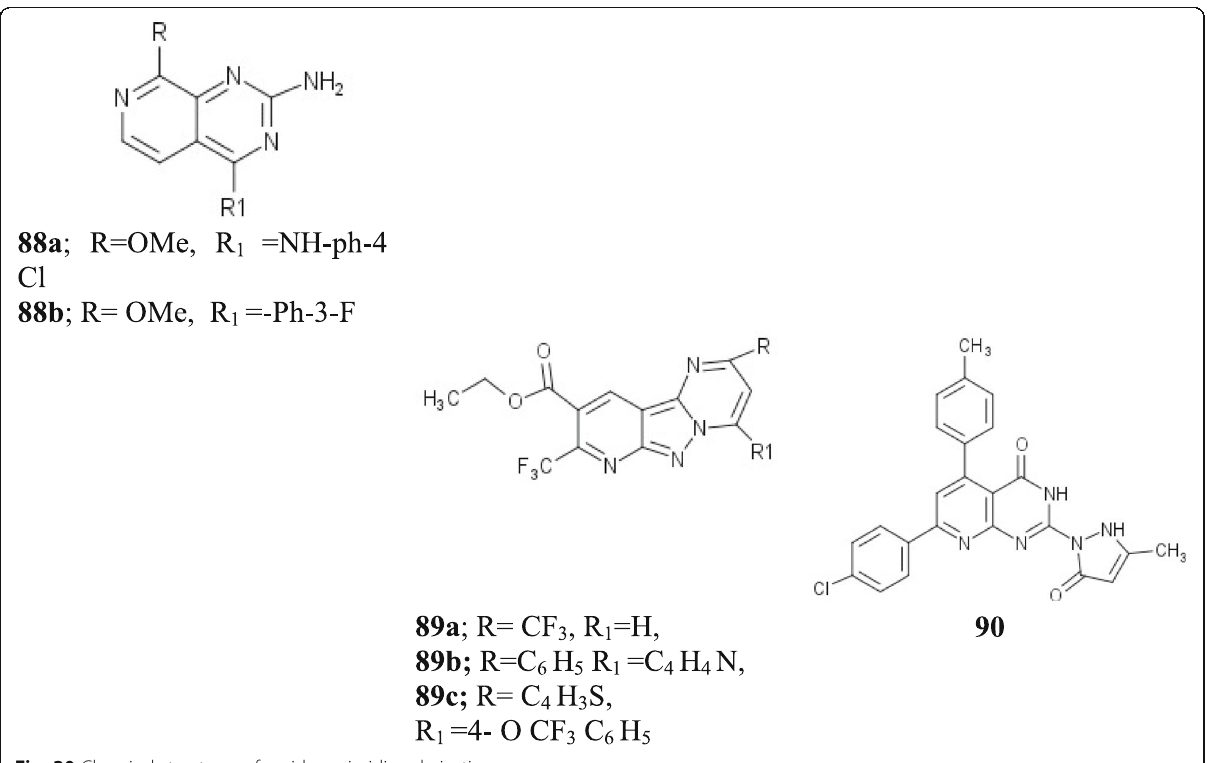
Fig. 30 Chemical structures of pyrido pyrimidine